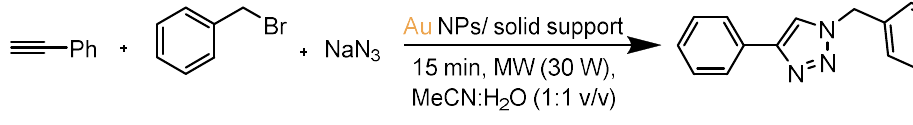
Table 3. Selected data for the microwave-assisted synthesis of 1-benzyl-4-phenyl-1H-1,2,3-triazole catalyzed by Au nanoparticles on different metal oxide supports a